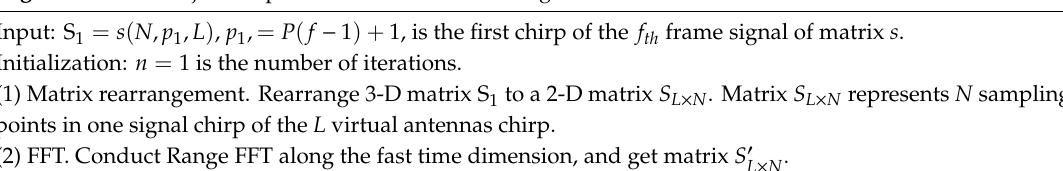
Algorithm 1 RFBM joint super-resolution estimation